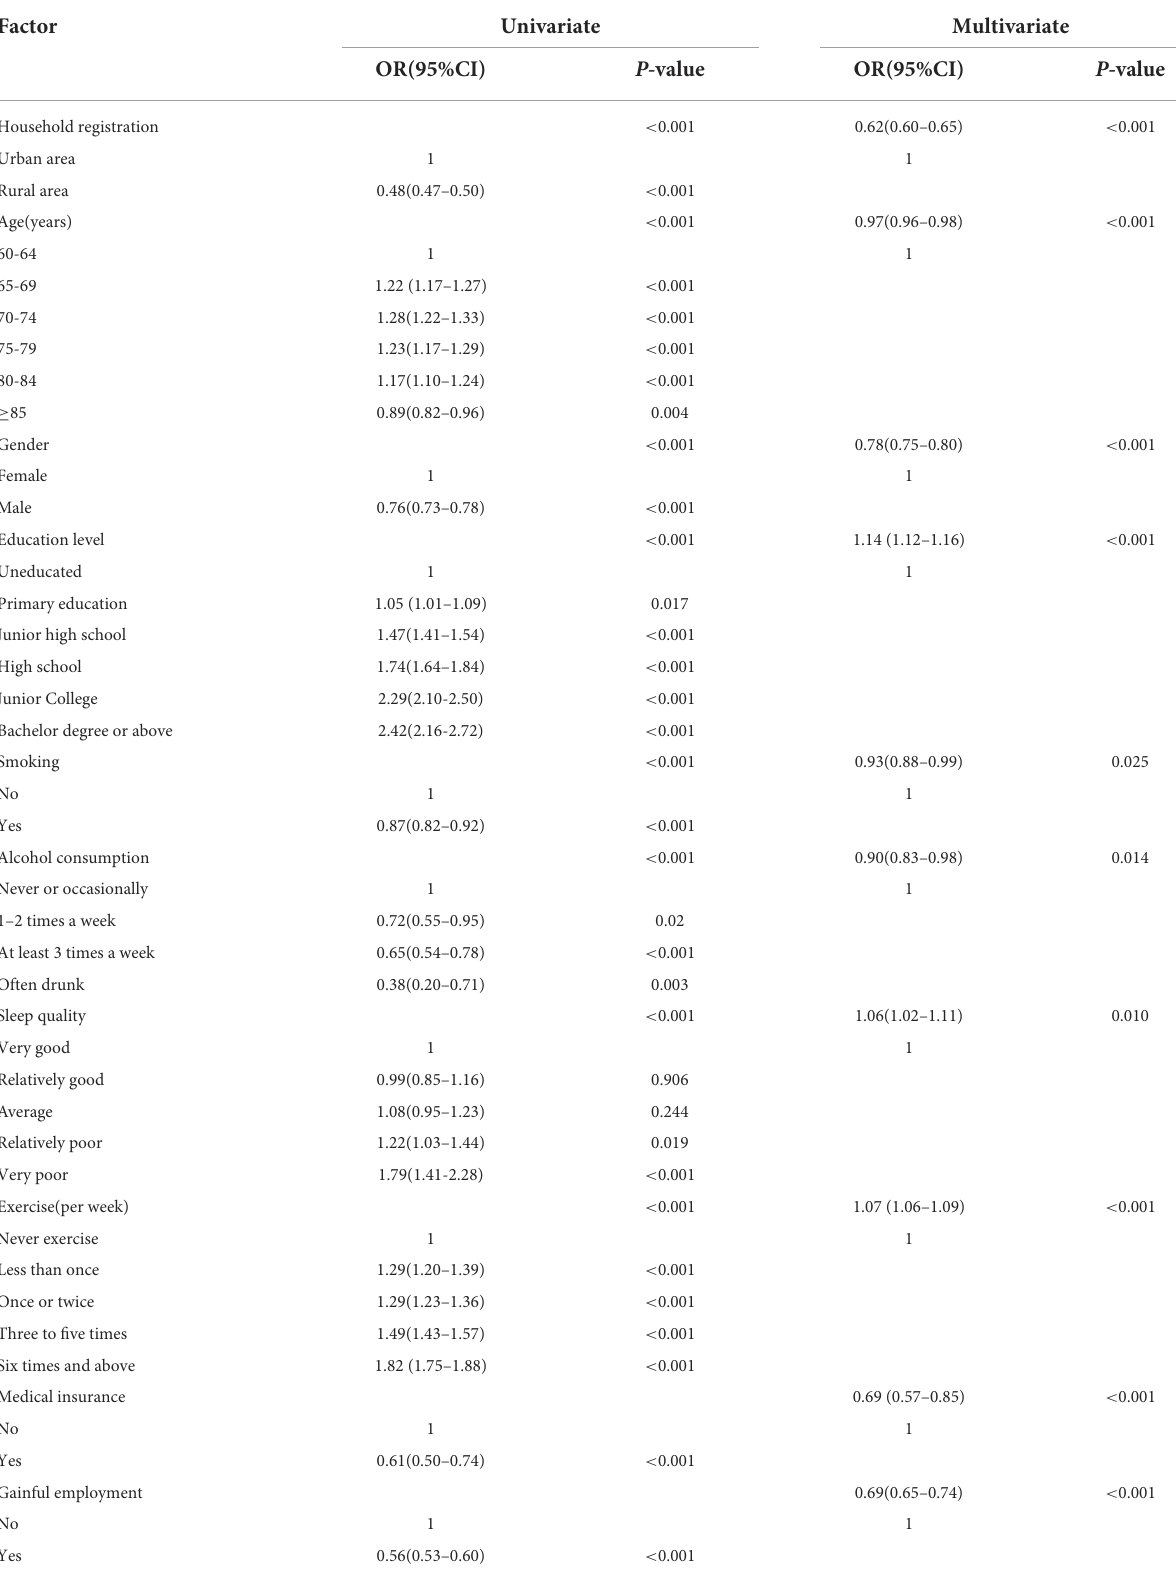
TABLE 3 Univariate and multivariate logistic analysis for diabetes. Factor Univariate